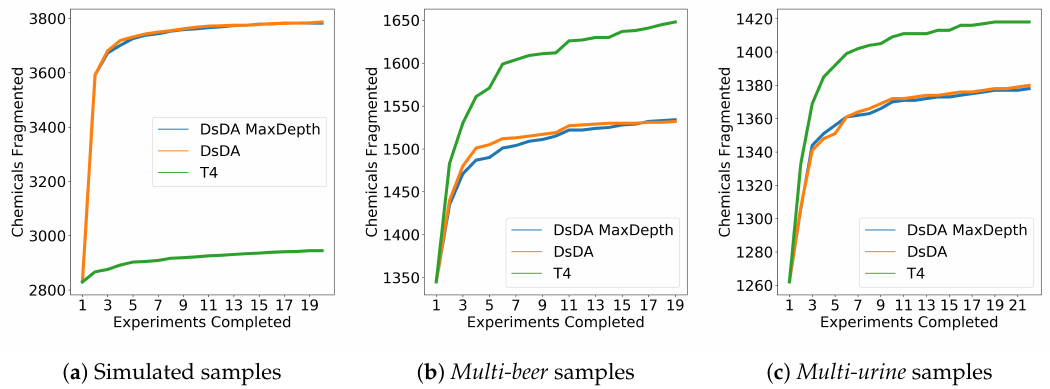
Figure 7. Top 4, DsDA and DsDA MaxDepth performance for in terms of the number of chemicals fragmented for ( a ) the simulated samples, ( b ) the multi-beer samples and ( c ) the multi-urine